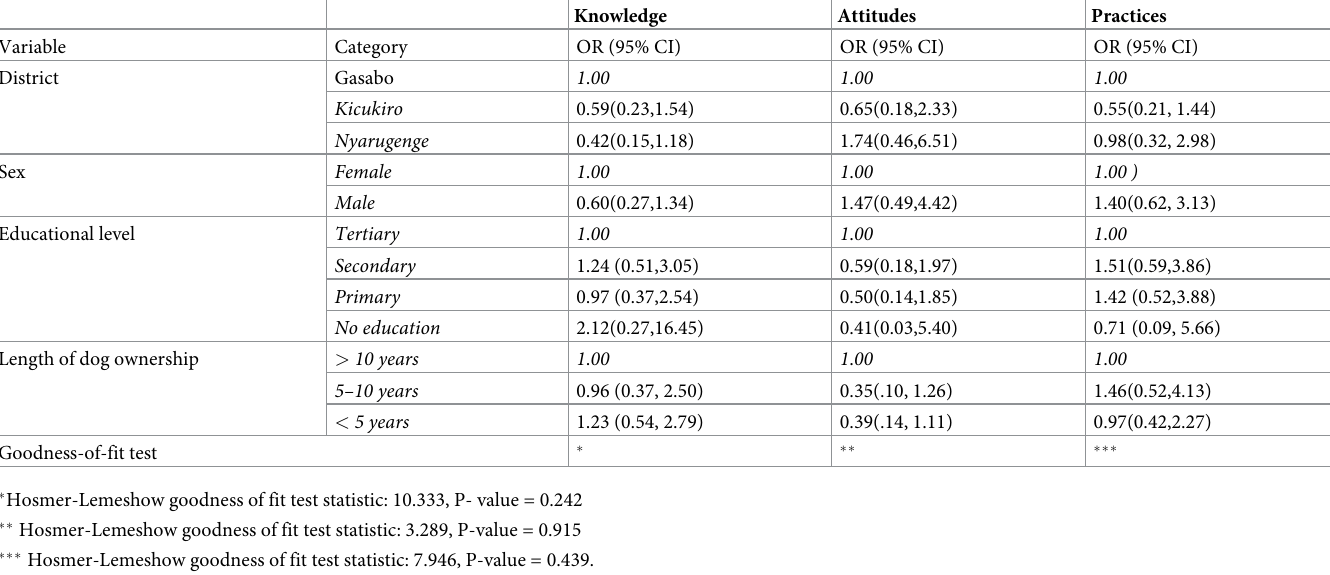
Table 6. Multivariable logistic regression analysis of factors of knowledge, attitudes and practices towards rabies in Kigali city. Knowledge Attitudes